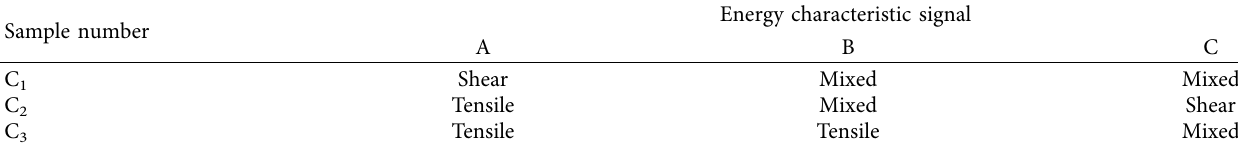
Table 3: Key location feature signal damage types.